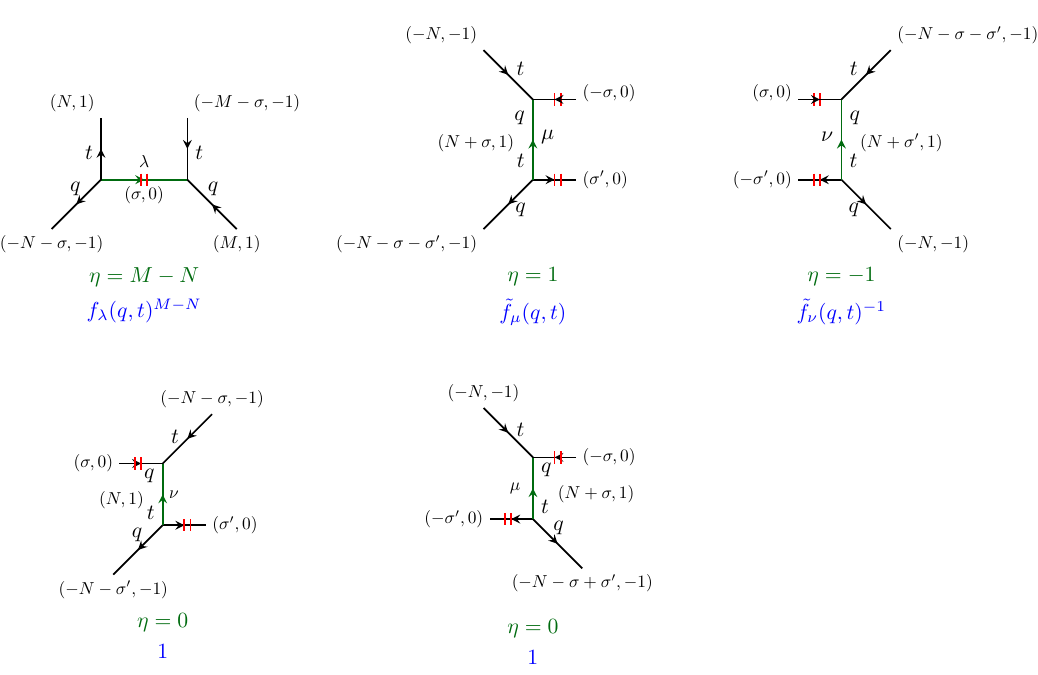
Figure 7 . The five patterns of framing factors that appear in this paper. The integer η associated with the green edge is written in green. The framing factor for each pattern is written in blue. The parity σ, σ = ± 1 depends on whether the edges in the preferred direction are in dashed lines or not. When σ = +1 , they are positive D-branes and when σ = − 1 , they are negative